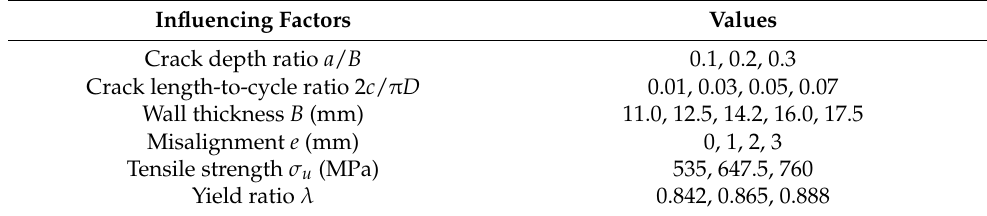
Table 2. Value ranges of the investigated influencing